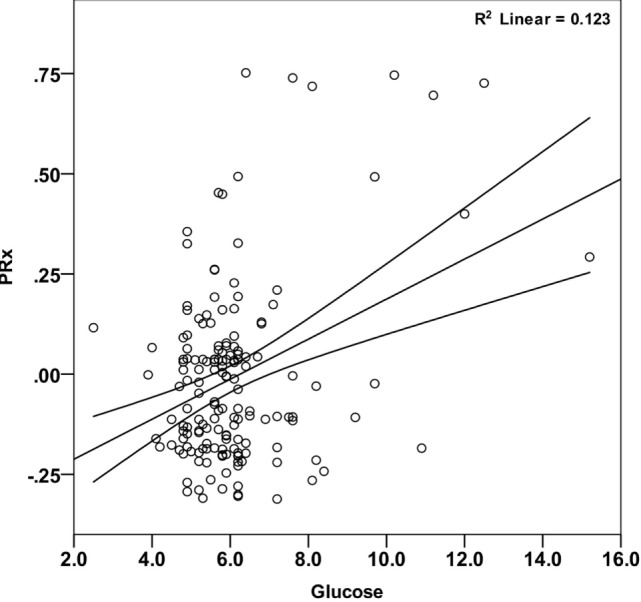
Correlation between mean arterial glucose and PRx in pediatric traumatic brain injury patients during the first 5 days since ictus. There was a significant positive relationship between blood glucose and PRx (Pearson correlation = 0.351; p < 0.001). Each data point represents the mean of the available arterial glucose concentration and PRx measurements during the first 5 days since ictus.